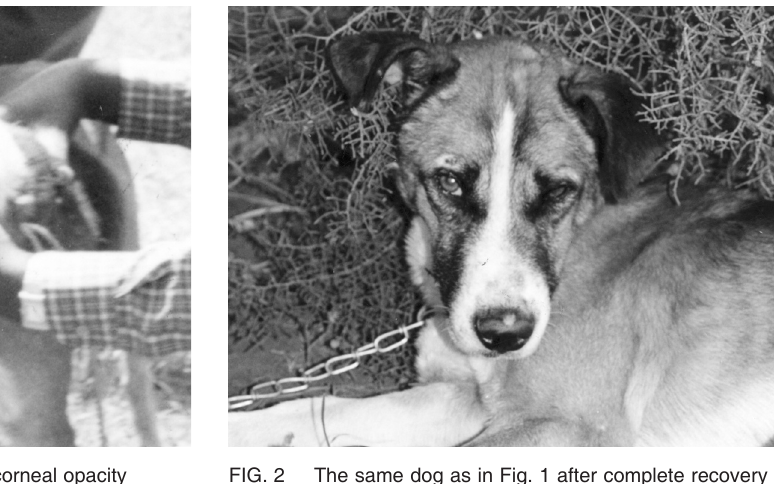
FIG. 2 The same dog as in Fig. 1 after complete recovery of the